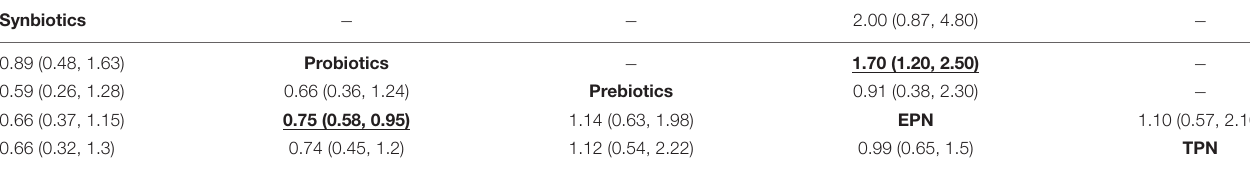
TABLE 4 | Results from pairwise meta-analysis and network meta-analysis on ventilator-associated pneumonia. Synbiotics